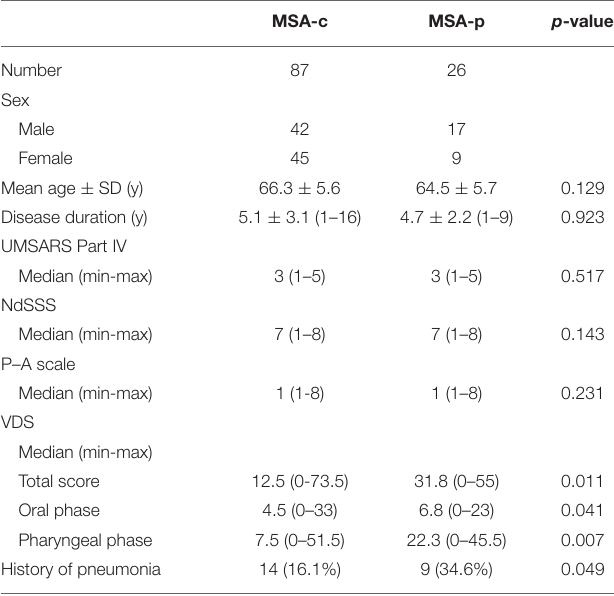
TABLE 8 | Differences between MSA subtypes in terms of clinical evaluations and videofluorographic swallowing